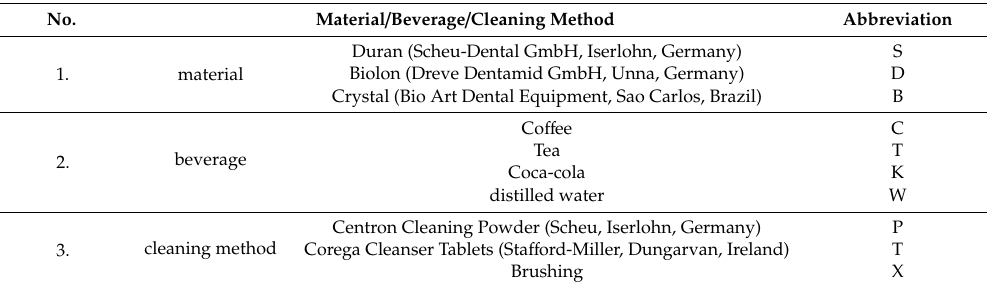
Table 2. Abbreviations used for the samples in the study.